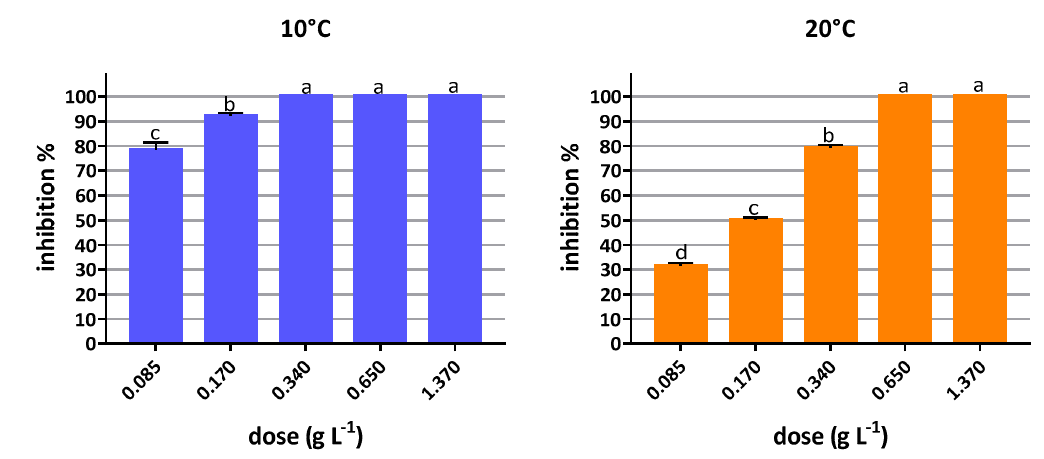
Figure 5. Percent inhibition of F. circinatum mycelial growth at two different temperatures (10 ◦ C and 20 ◦ C) with the dose of BioFence ® 0.0850, 0.17, 0.34, 0.68 and 1.37 g L − 1 . No significant differences were found between the isolates FcCa1 and Fc015; thus, data were combined for the statistical analysis. Different letters indicate significant differences at p < 0.05 according to Tukey’s post-hoc test. Vertical bars = SE. The dose of 1.37 g L − 1 was fungicidal as no growth was observed once the pellets were removed and the plates were incubated for 30 days. In contrast, 0.34 and 0.68 g L − 1 were fungistatic at 10 and 20 ◦ C respectively, causing 100% inhibition for 6 days after